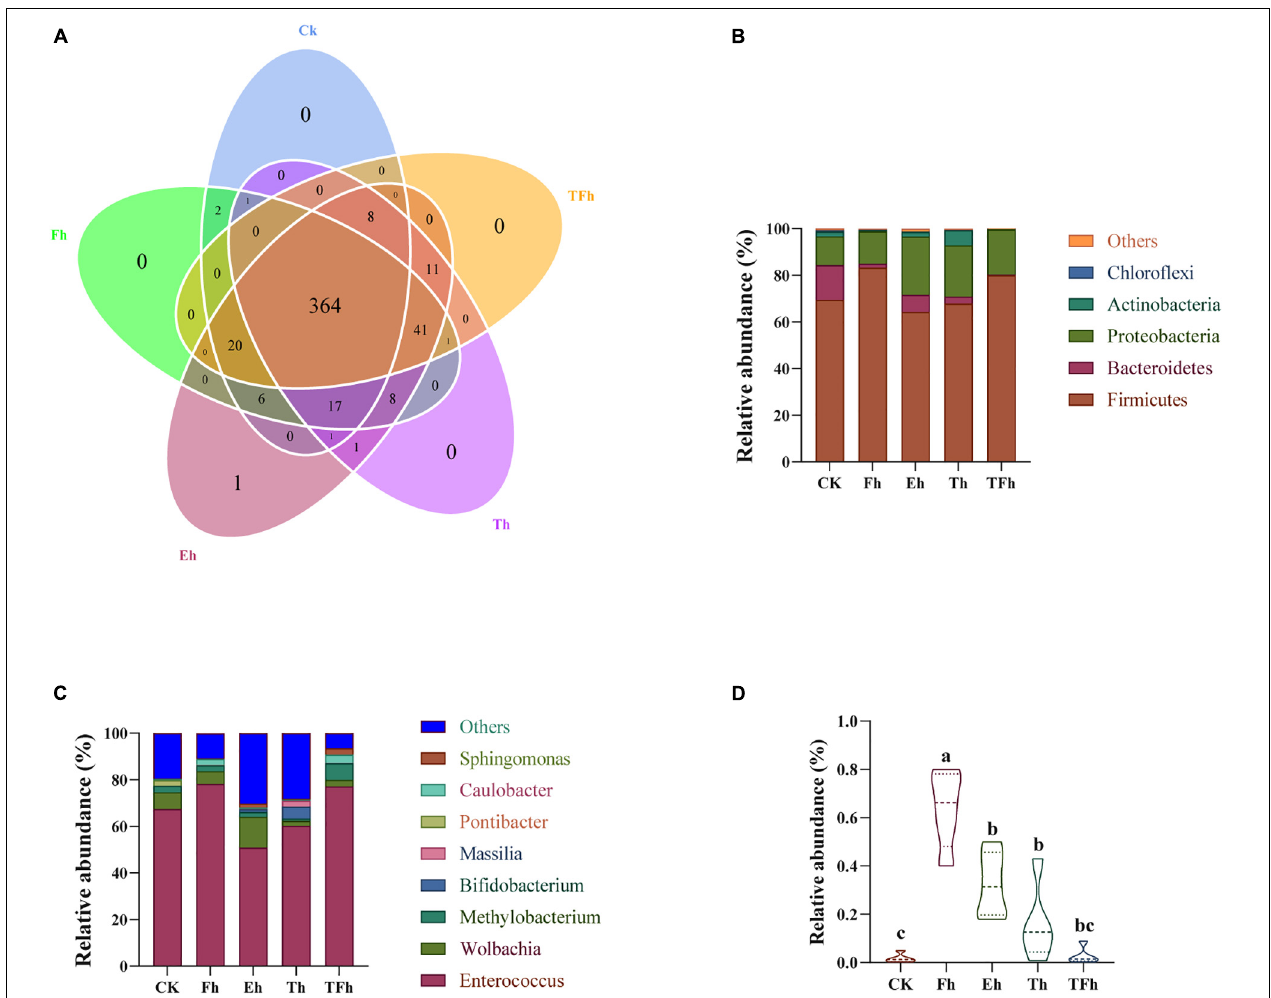
FIGURE 4 | Venn diagram (A) of the operational taxonomic units (OTUs) in CK, Fh, Eh, Th, and TFh. Relative abundances are shown for bacteria at the phylum (B) and genus (C) levels. CK: no starvation treatment; Fh: 4 h starvation treatment; Eh: 8 h starvation treatment; Th: 12 h starvation treatment; TFh: Twenty-four hours starvation treatment. (D) The relative abundance of Bacillus